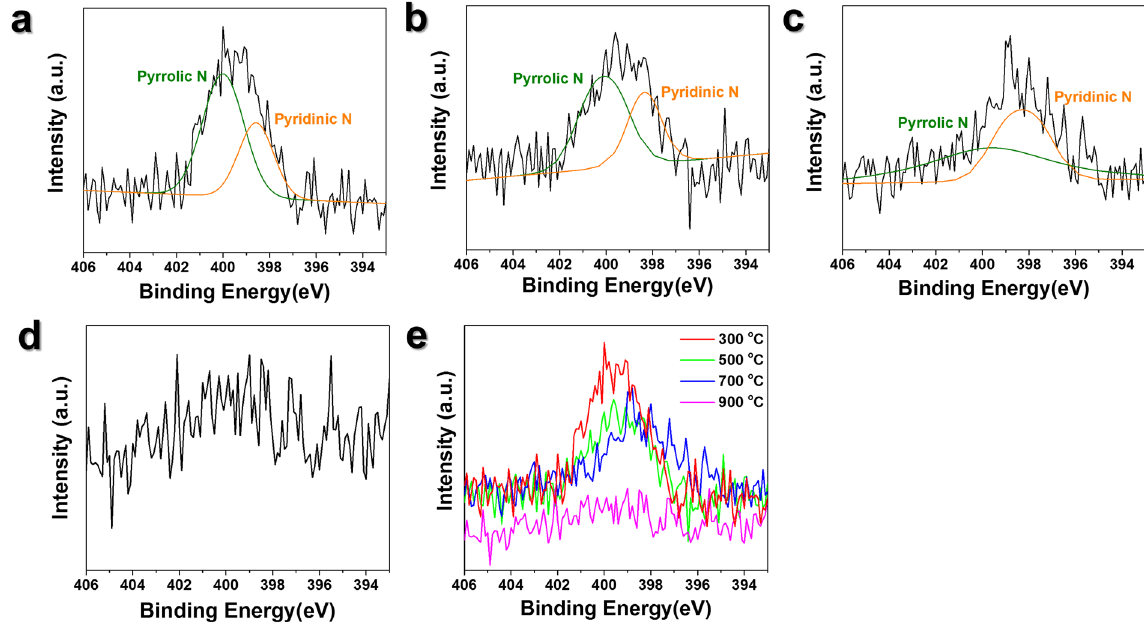
Figure 3. XPS analysis for N1s of Fe-pyPANI-K pyrolyzed at various temperatures. ( a ) 300 °C, ( b ) 500 °C, ( c ) 700 °C, ( d ) 900 °C ( e ) variation of XPS peak shift with pyrolysis temperature. ( a – c ) Green line indicates pyrrolic N and Orange line indicates pyridinic N.